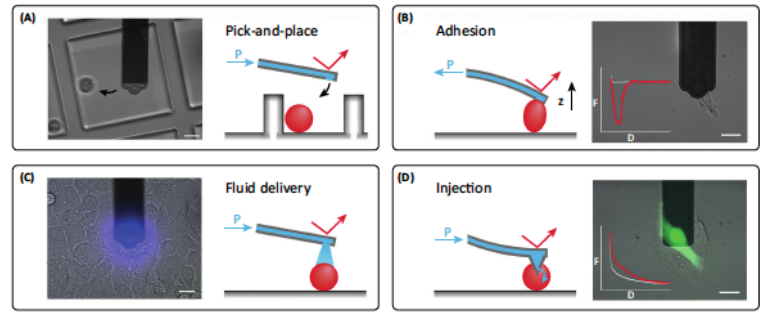
Figure 26. Various actions that can be performed on a living cell using hollow AFM cantilever. The scale bars are 20 microns. Reprinted with permission from